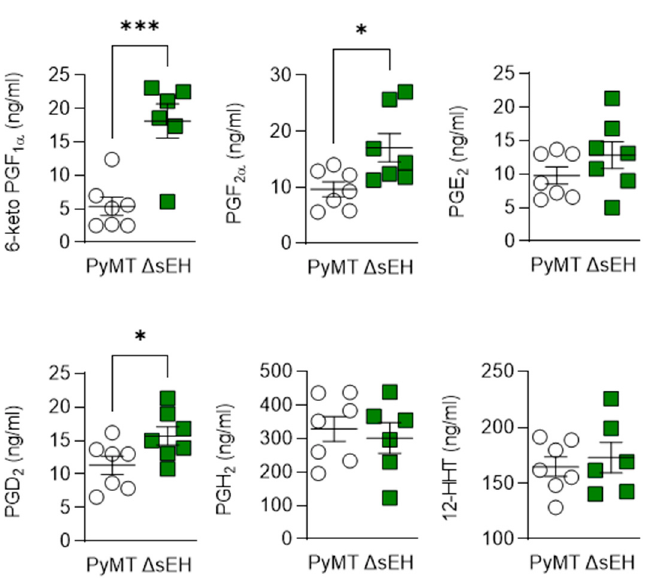
Figure 7. Consequences of Cyp2c44 and sEH deletion on the prostaglandin profile in breast cancer tumors. Tumors were isolated from 20-week-old PyMT and PyMT Δ sEH ( Δ sEH) mice and prostaglandin (PG) levels assessed by LC–MS/MS. The graphs summarize data from n = 6–7 different animals in each group. * p < 0.05, *** p < 0.001 (Student’s t test).